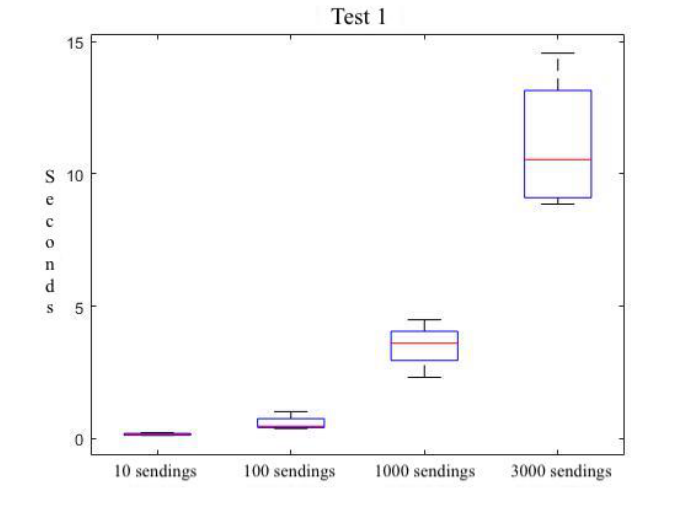
Figure 9. Summary of temporal behavior of test 1.